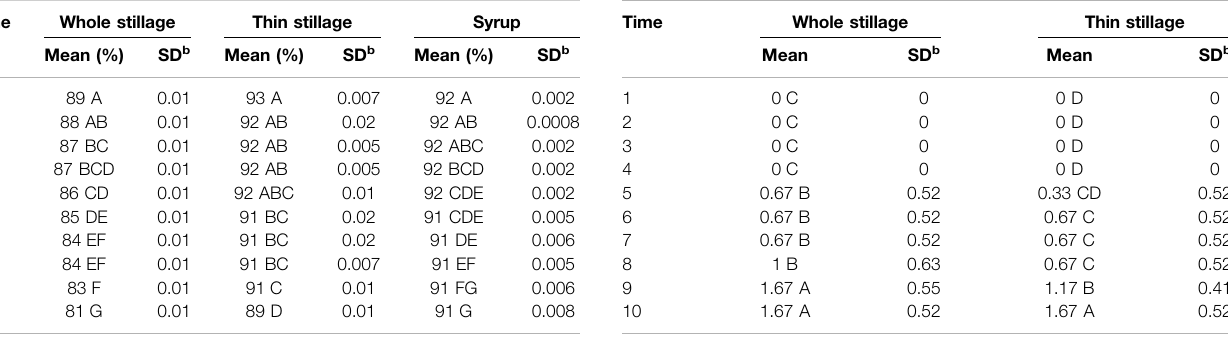
TABLE 5 | Mold development in whole stillage and thin stillage over time.